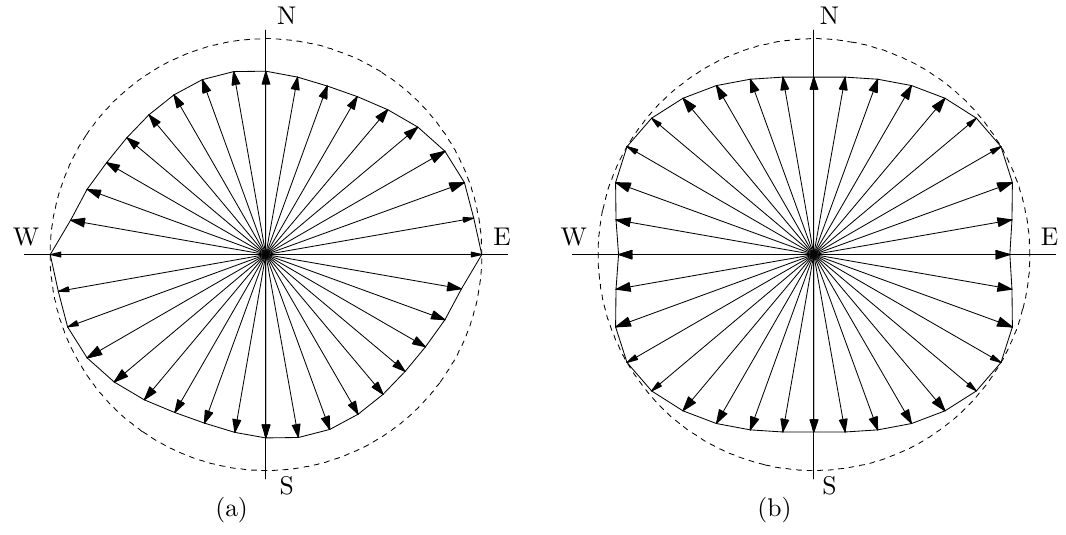
FIG. 7: Total kinetic energy computed three days after the wind set-up (steady state) subject to constant wind from different directions with the vertical eddy viscosity ν v = 0 . 02 m 2 s − 1 . The computations are performed for two case: (a) the Coriolis force effect is considered; (b) the Coriolis force is neglected. The directions of the drawn arrows are the wind directions (for an interval of 10 ◦ ) around the basin, their lengths indicate the magnitudes of the total kinetic energy. The dashed circles show the maximum value of the total kinetic energy in all directions, which is 5 . 24 × 10 9 Nm for (a), but 4 . 49 × 10 10 Nm for (b).